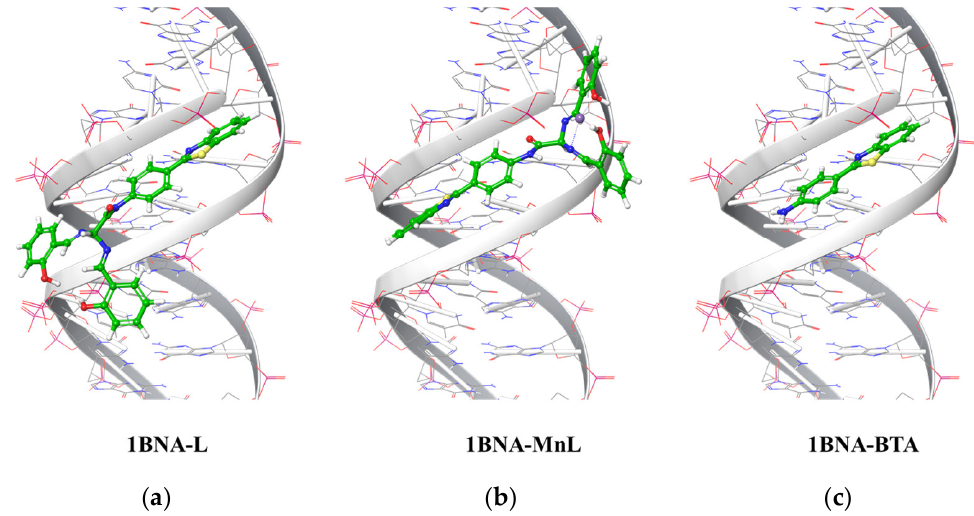
Figure 6. DNA binding configurations as predicted for the compounds ( a ) L , ( b ) MnL , and ( c ) BTA (PDB ID: 1BNA).